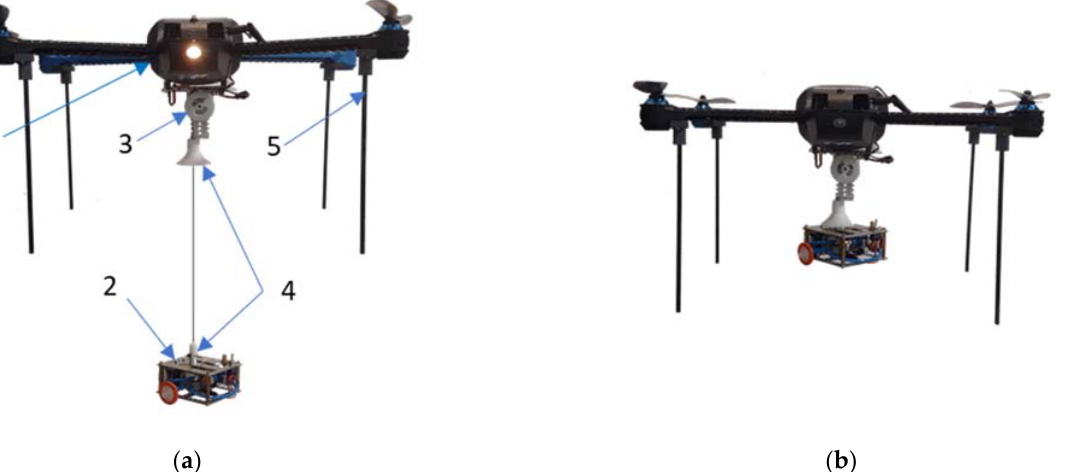
Figure 1. Gas sensing drone, when the measurement platform is: ( a ) lowered; ( b ) docked under the drone. (1) UAV (quadrocopter); (2) Gas sensing platform; (3) Equipment for lowering and lifting the measurement module; (4) Docking system; (5) Landing gear.